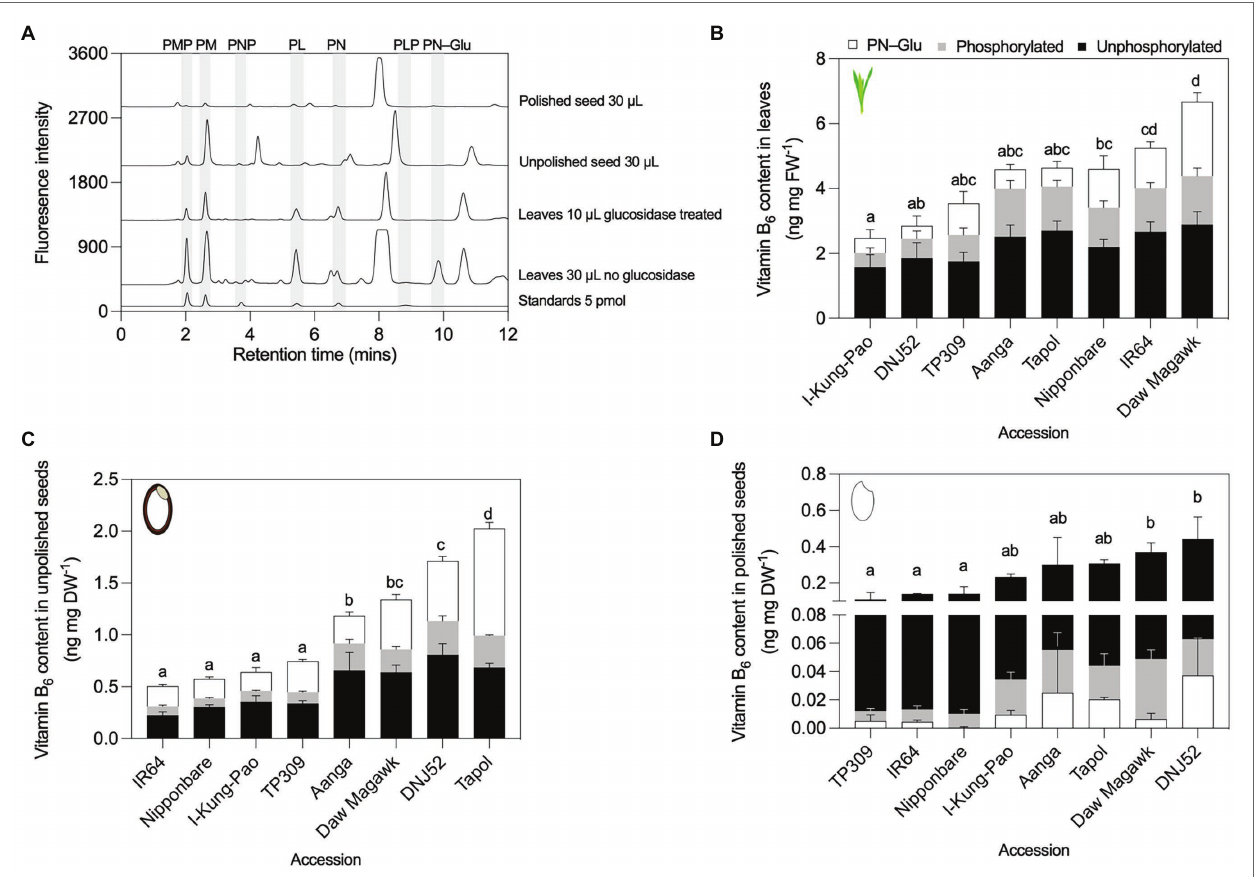
FIGURE 5 | HPLC profiling of B 6 vitamers in leaves and seeds of rice accessions contrasting in total vitamin B 6 contents. (A) Representative HPLC chromatograms of leaf and seed tissues. To facilitate visualization, chromatograms were offset from the baseline of the standards by 300 units for leaves 30 μ l injected no glucosidase, 1,200 units for leaves 10 μ l injected glucosidase treated, 2,000 units for unpolished seed, and 2,700 units for polished seed. HPLC analysis of B 6 vitamers in leaves (B) , unpolished seeds (C) , and polished seeds (D) . Samples were obtained from plant material grown under greenhouse conditions in experiment 2. Leaves were sampled from 40-day-old plants. Seed samples were obtained from fully mature pannicles and dried before extraction. Data are the mean ± standard deviation of n = 3 biological replicates. The effect of accession on total vitamin B 6 contents in panels (B–D) was determined by one-way ANOVA ( α = 0.05) with multiple comparisons and Tukey’s post-hoc test. Statistically significant differences between accessions are denoted by different